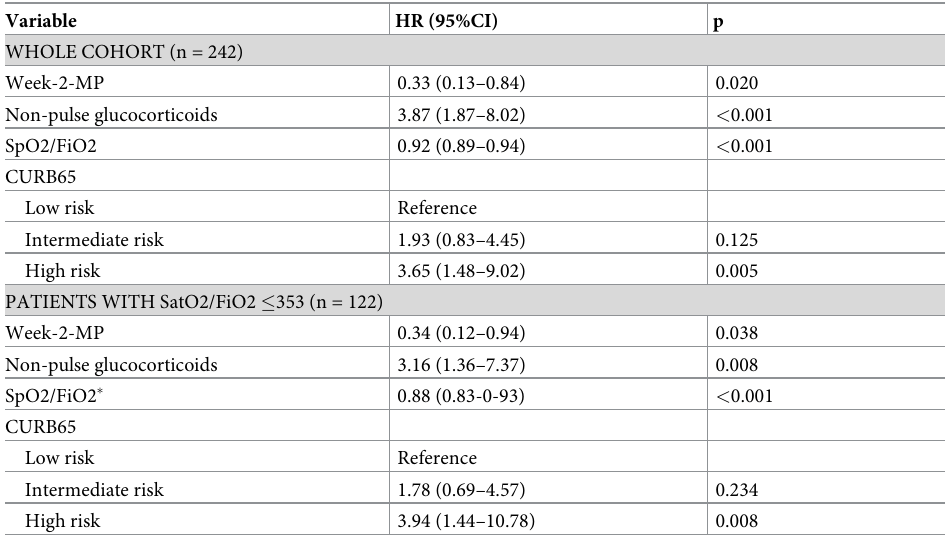
Table 3. Predictors of death or intubation: Final models.